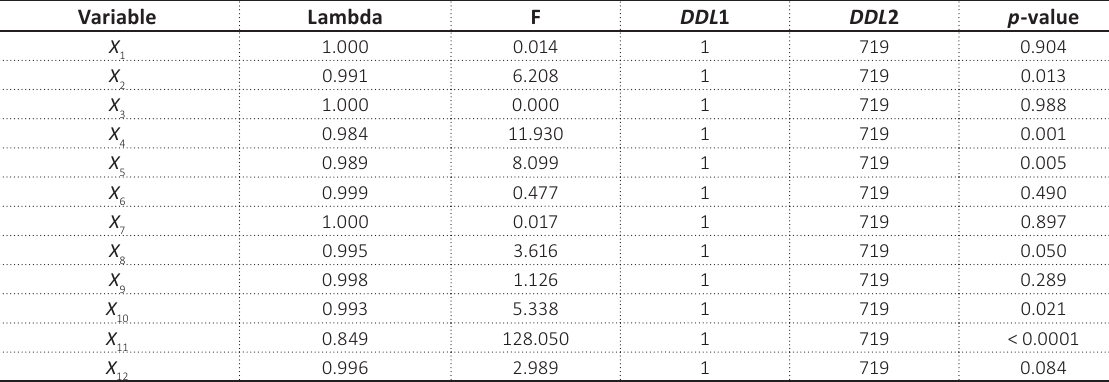
Table B3. Linear discriminant analysis of univariate